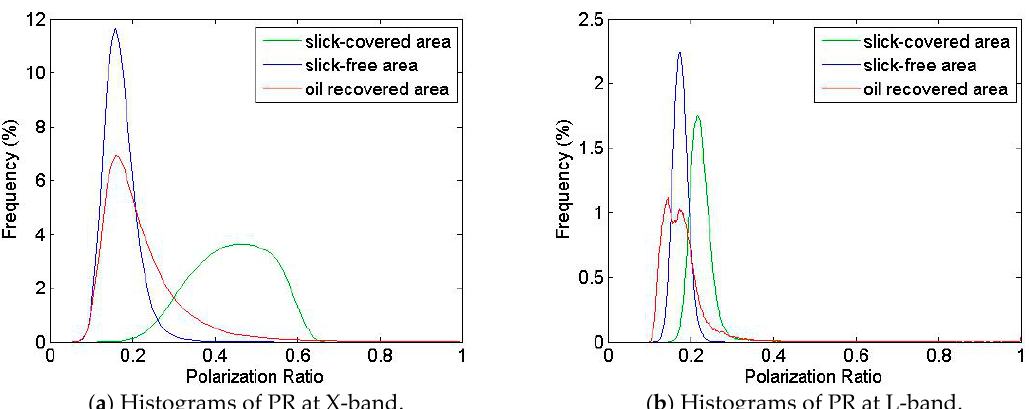
Figure 18. SETHI NOFO’2015 on 9 June 2015 at 10:01 a.m. UTC, histograms of PR parameter at: ( a ) X-band; and ( b ) L-band over slick-covered (green), slick-free (blue) and oil recovered areas (red).